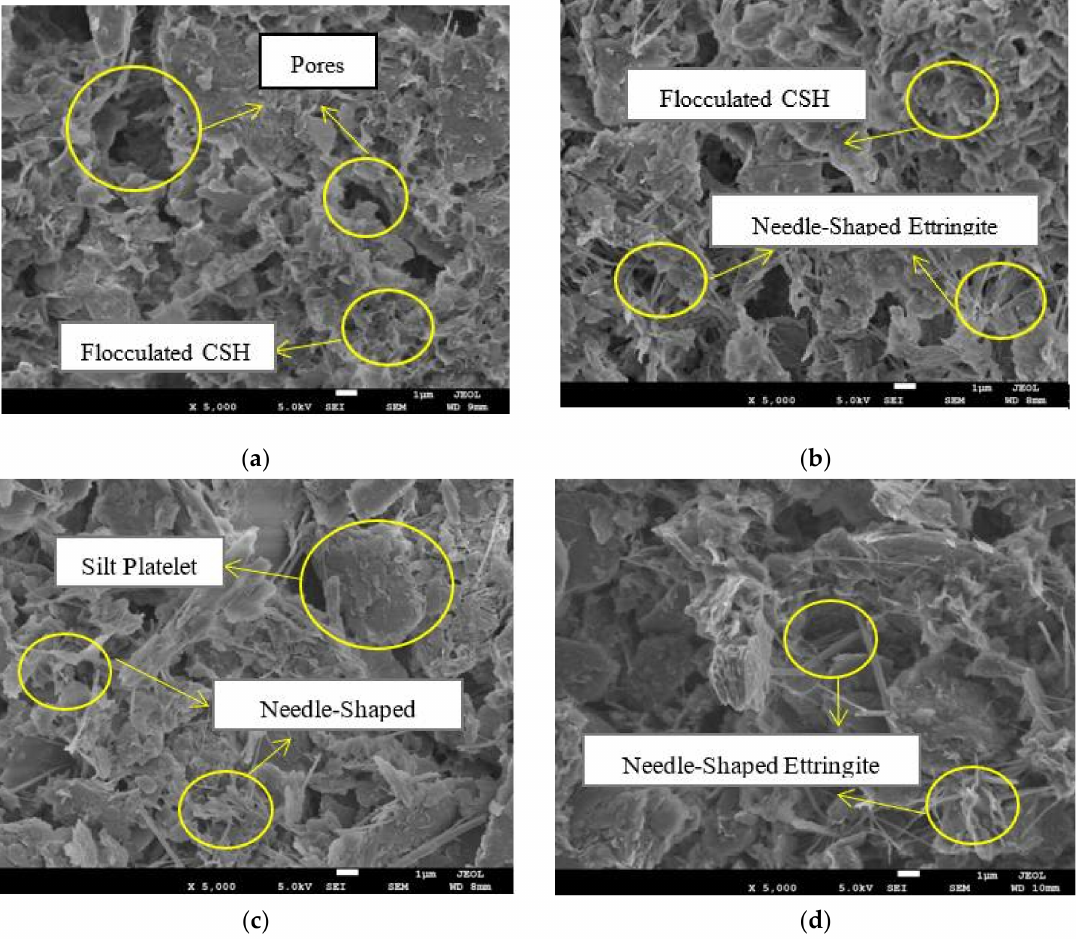
Figure 12. SEM images of specimen treated by 10% cement with different silt contents: ( a ) S1 + 10% cement, ( b ) S2 + 10% cement, ( c ) S3 + 10% cement, ( d ) S4 + 10%